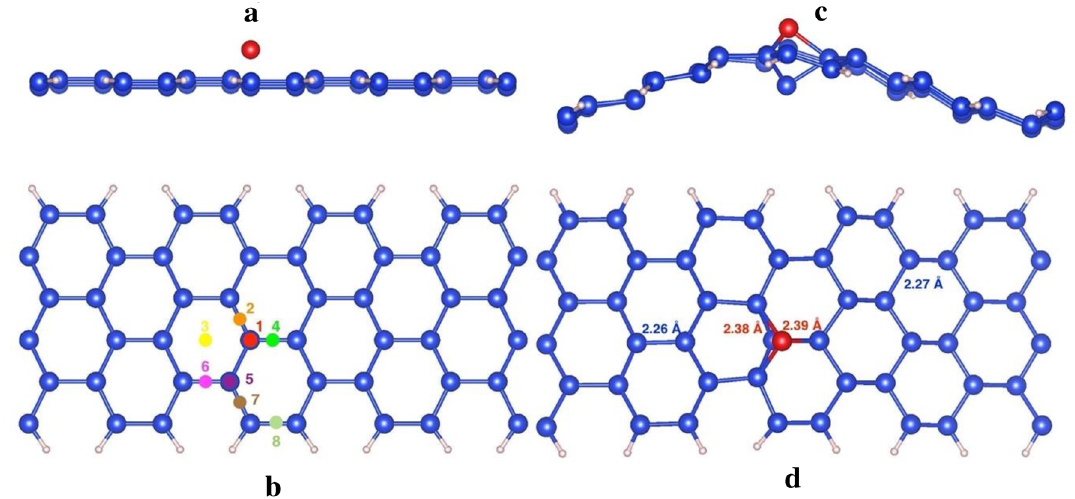
Figure 1. ASiNRs:H from the side ( a ) and top view with 8 different absorbed positions ( b ). ASiNRs:H with a single—diatom (site 1) from the side ( c ) and top view ( d ). The blue and pink balls represent for Si and H in ASiNRs:H, respectively. The red ball is the adsorbed Si’ atom at site